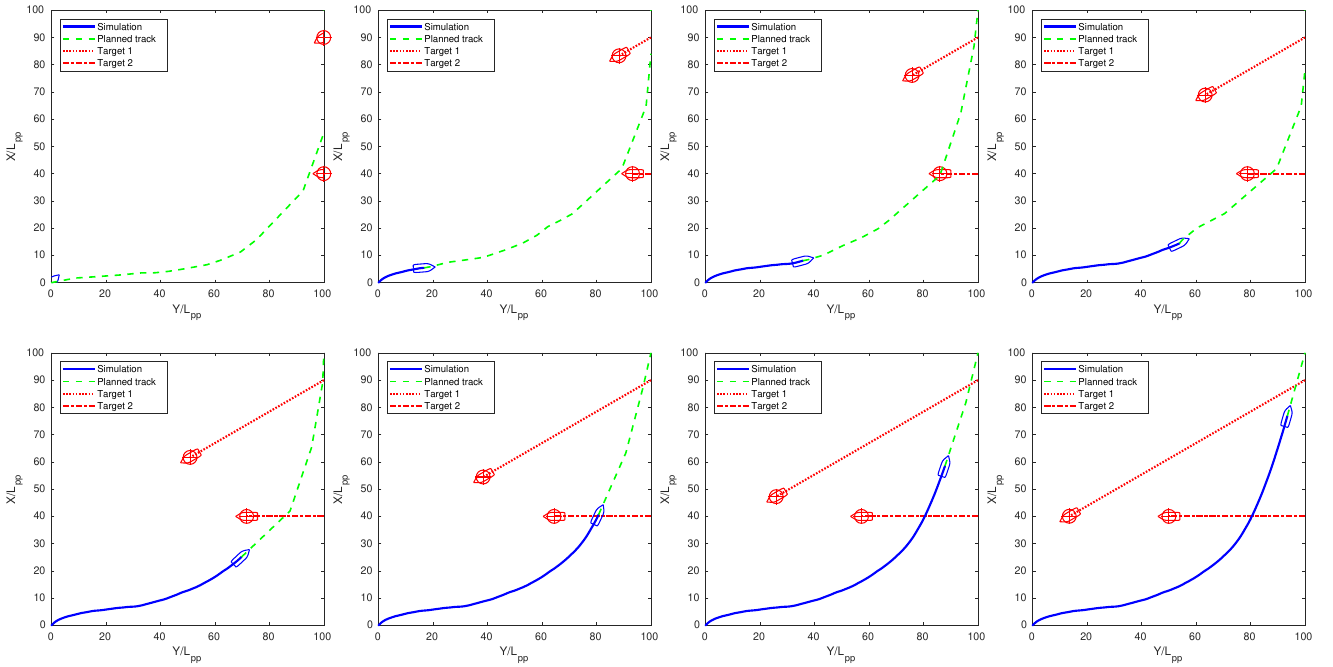
Figure 11. Scenario 2: simulation of a COLREG-compliant